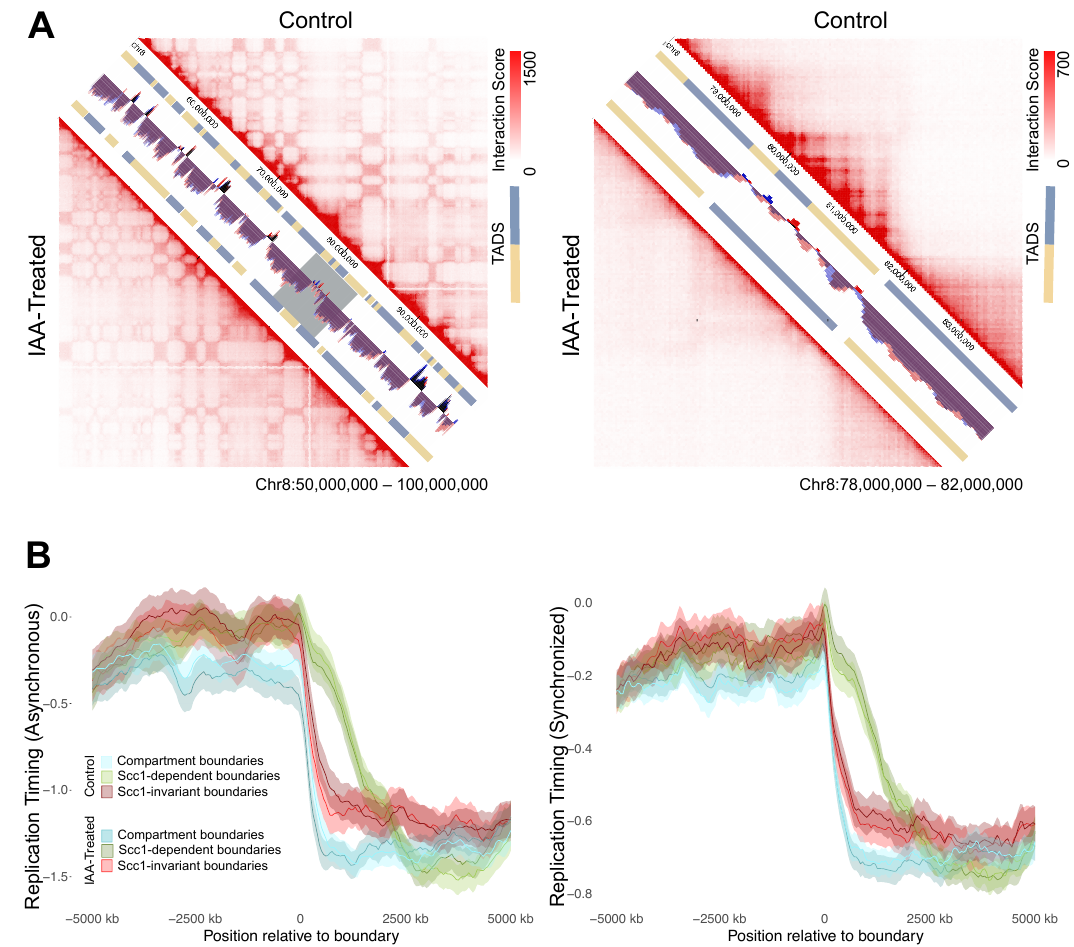
Figure 5. Replication timing across TAD boundaries versus compartment boundaries. ( A ) Visualization of HiC data from Rao et al. (2017) [30] in untreated cells versus auxin-treated cells. The left panel spans 50 Mb to highlight compartments and the right zooms in to 6 Mb from within that locus (gray box) to highlight changes to TAD structure. ( B ) Replication timing metaplots for windows 5 Mb on either side of TAD boundaries. Invariant boundaries are those called in both control and auxin-treated cells, Scc1-dependent boundaries are those that were lost upon auxin